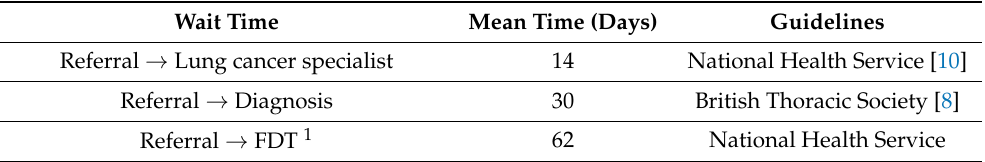
Table 1. Recommended wait times for lung cancer